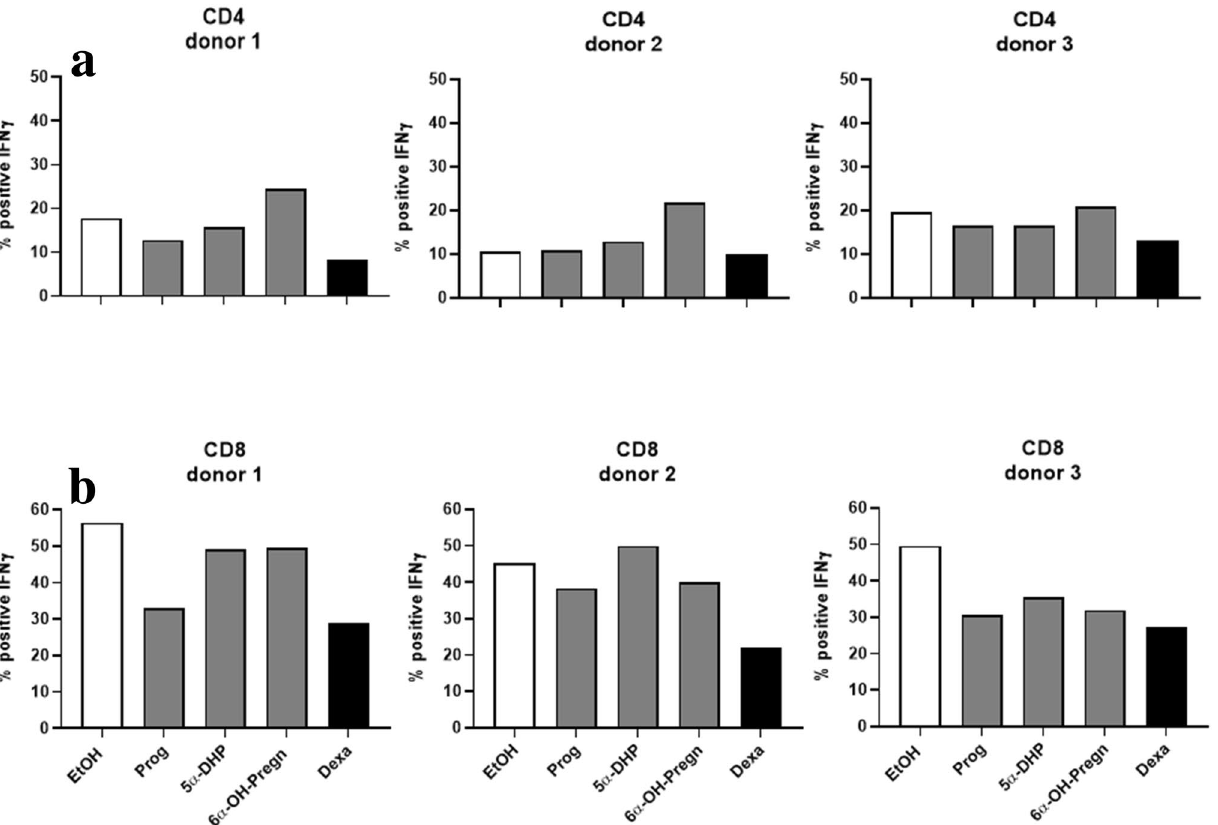
Figure 9. IFN-γ production in CD4+ and CD8+ T cells upon stimulation with progesterone metabolites. Progesterone (Prog), 5α-dihydroprogesterone (5α-DHP), 6α-hydroxypregnanolone (6α-OH-Pregn) and dexamethasone (Dexa), were added at a concentration of 10 −3 M to the PBMCs of 3 different female donors for 24 h. 6 h after first steroid hormone contact, PBMCs were activated with PMA/Ionomycin. IFN-γ positive CD4+ and CD8+ T cells were counted by FACS analysis. The y-axis shows the % of CD4+ ( a ) and CD8+ ( b ) T cells positively staining for IFN-γ. * p < 0.05, ** p < 0.01, *** p < 0.0001, ns = not